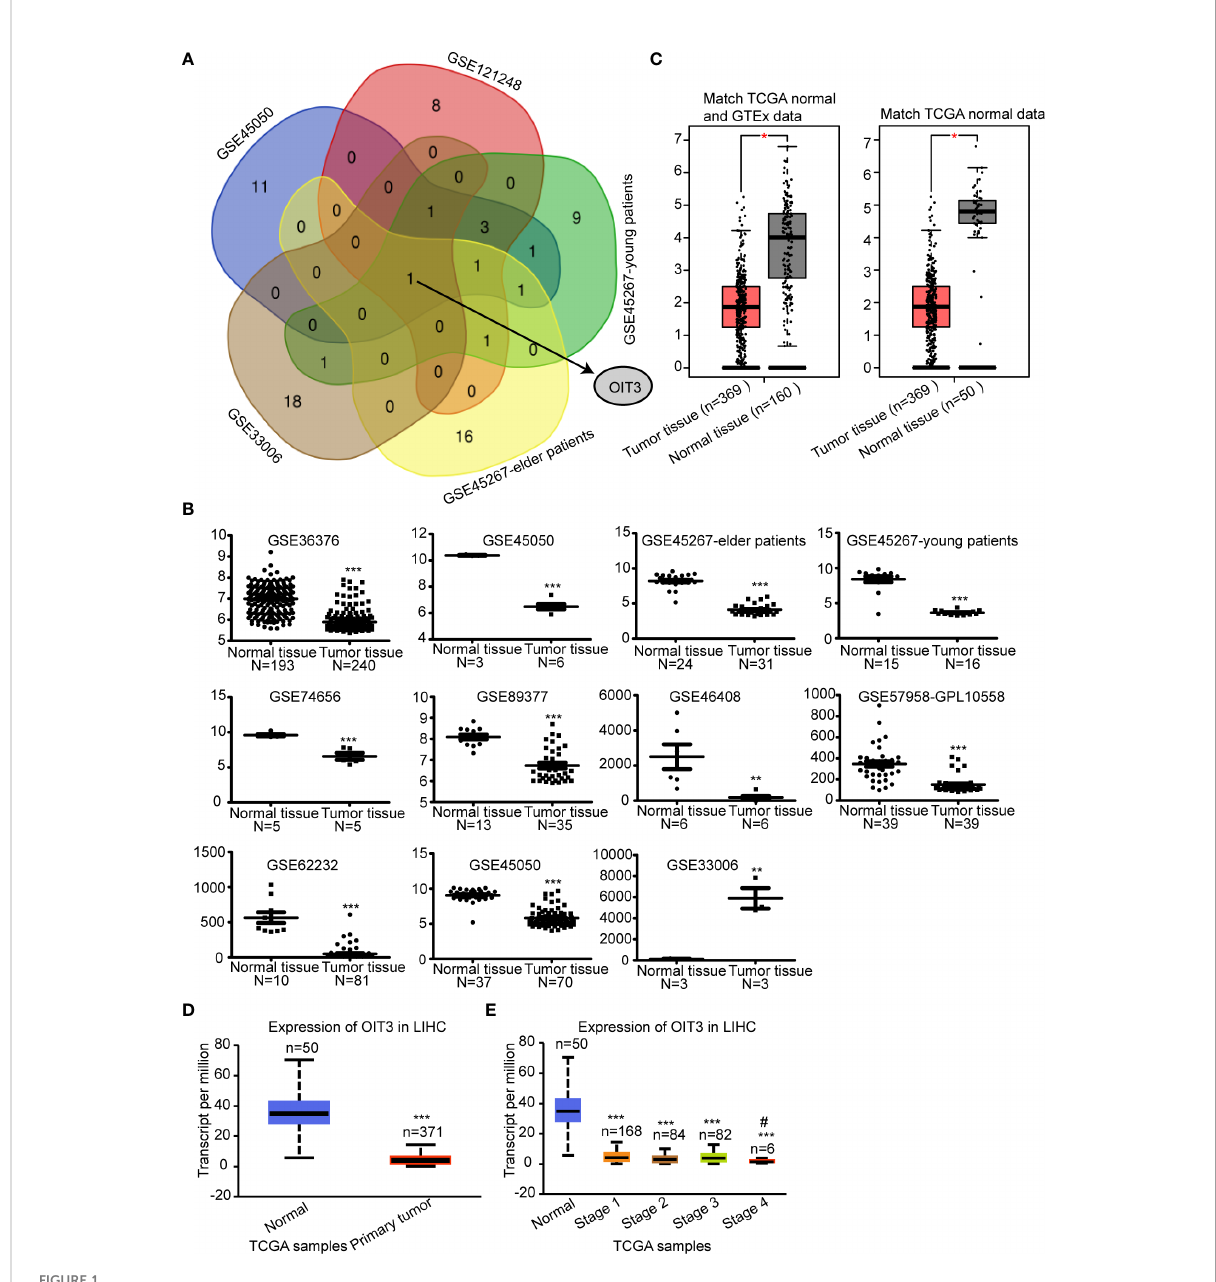
FIGURE 1 OIT3 was downregulated in HCC tissues. (A) OIT3 was a common differentially expressed mRNA among datasets, including GSE45050, GSE121248, GSE33006, GSE45267-elder patients, and GSE45267-young patients. (B) The expression levels of OIT3 in different GSE databases, including GSE36376, GSE45050, GSE45267-elder patients, GSE45267-young patients, GSE74656, GSE89377, GSE46408, GSE57958-GPL10558, GSE62232, GSE45050 and GSE33006. ( **P < 0.01 , ***P < 0.001 ). (C) OIT3 expression level in tumor tissues and normal tissues of HCC patients in the GEPIA database. The gene expression pro fi les of OIT3 from all available samples classi fi ed as LIHC tumor tissues and normal tissues in TCGA and GTEx were chosen to perform differential analysis in GEPIA. ( *P < 0.05 ). (D) OIT3 expression level in tumor tissues and normal tissues of LIHC patients in Ualcan database ( ***P < 0.001 ). (E) OIT3 expression in HCC patients at different stages of LIHC patients in Ualcan database (AJCC stage. stage 1, stage 2, stage 3 and stage 4 group compared with the normal group, ***P < 0.001 . Stage 3 group compared with stage 4 group, # P < 0.05 ). LIHC, Liver hepatocellular